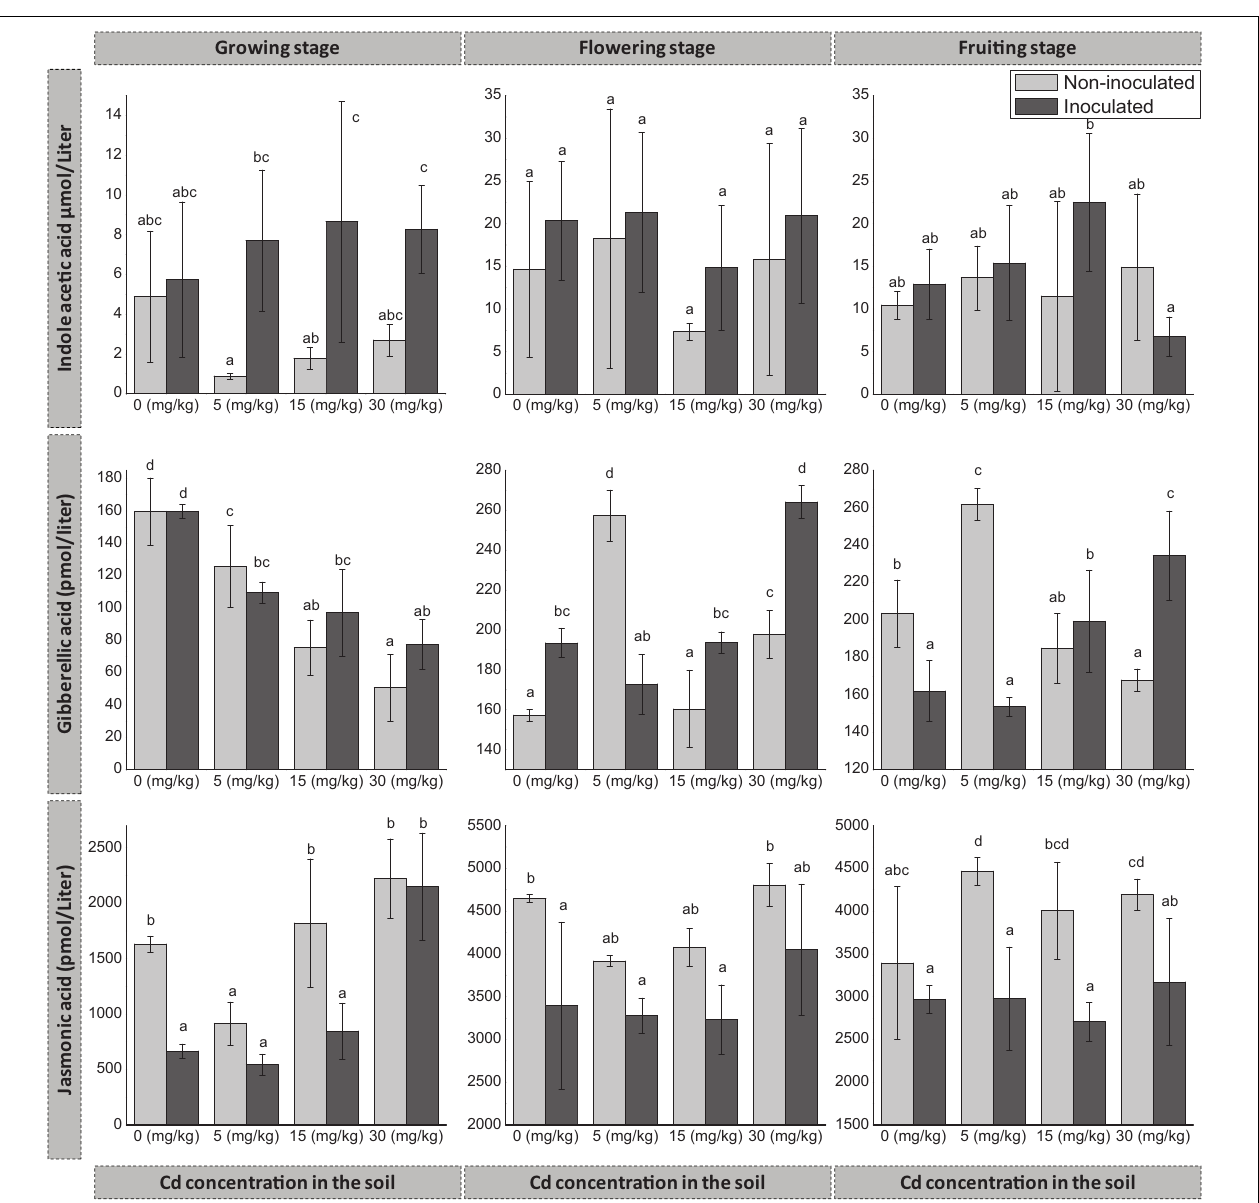
FIGURE 4 | Effects of endophyte FZT214 on the endogenous phytohormone content of D. ambrosioides grown under different Cd concentrations at different developmental stages. The different lowercase letters indicate significant variation between treatments ( p < 0.05) according to Duncan’s test of one-way ANOVA (mean ± STD, n =